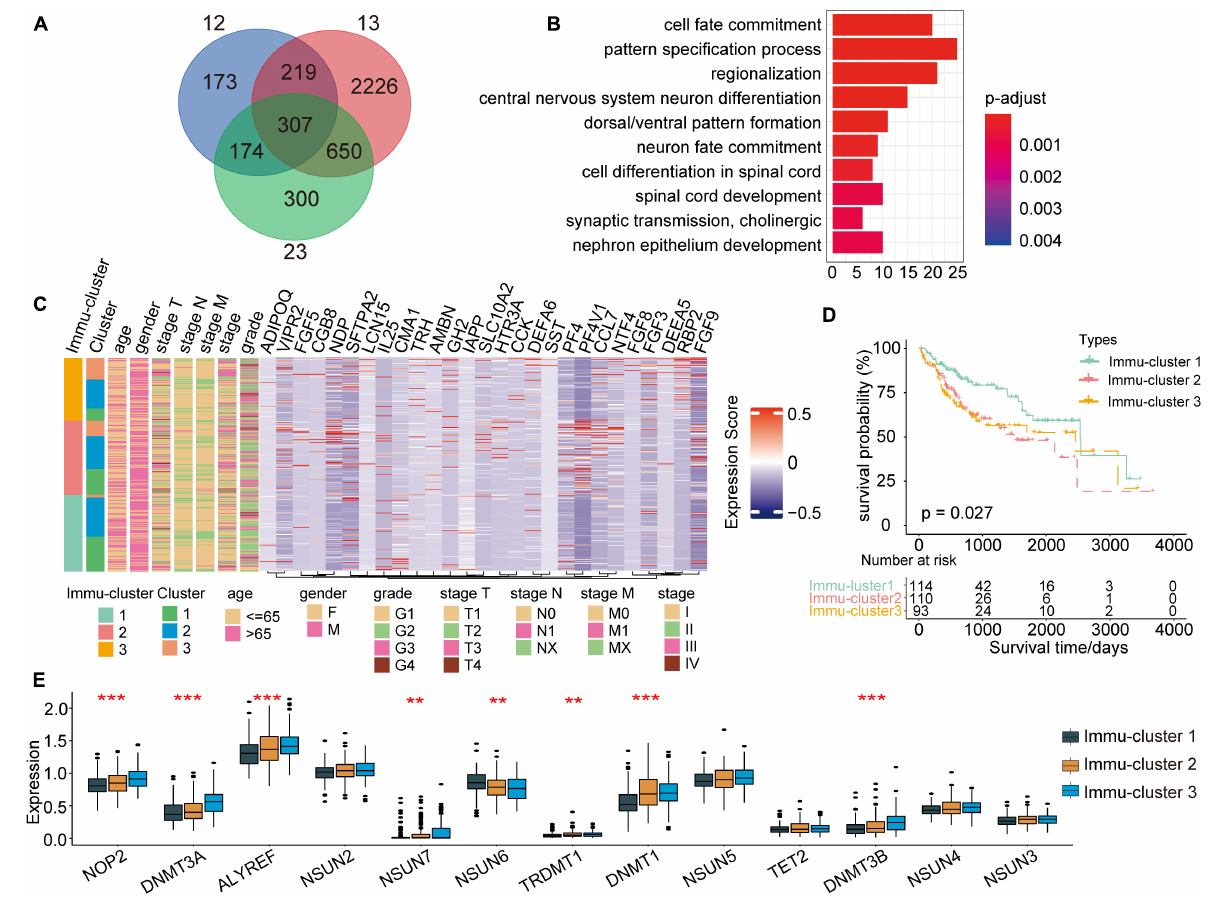
FIGURE 6 | Identification of distinct Immu-clusters based on immune-related DEGs in m 5 C modification patterns. (A) A total of 307 m 5 C-related DEGs between three m 5 C clusters were identified, as shown in the Venn diagram. (B) Enrichment of biological processes significantly related to DEGs. (C) The selected genes were used to classify patients into different genomic subtypes by unsupervised clustering analysis. (D) Kaplan–Meier curves indicated that the genomic subtypes were correlated with the prognosis of patients with HCC. (E) Significant differences in the expression of m 5 C regulators. ** p < 0.01, *** p <